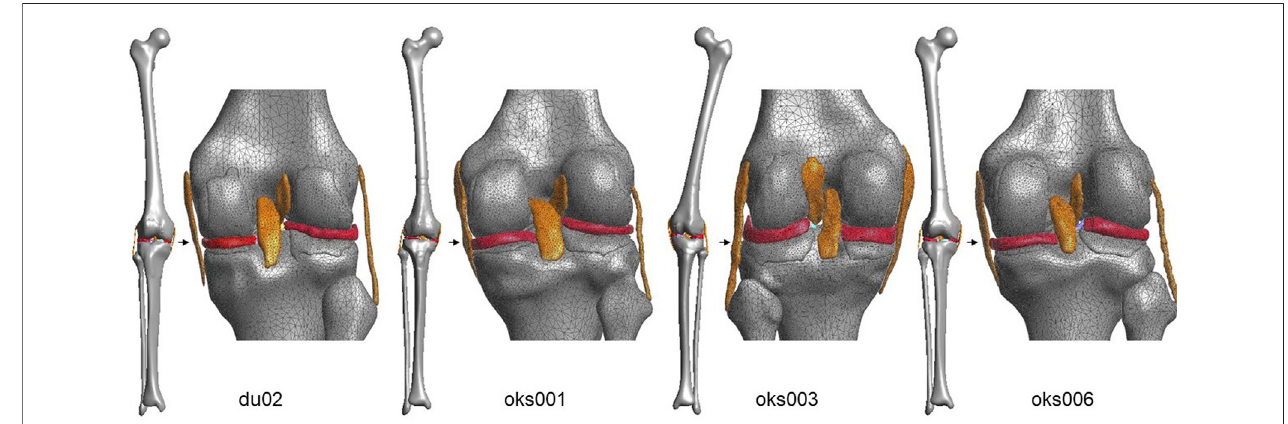
FIGURE 1 | Anterior (full-length bones) and posterior (articulating region) view of the four models.